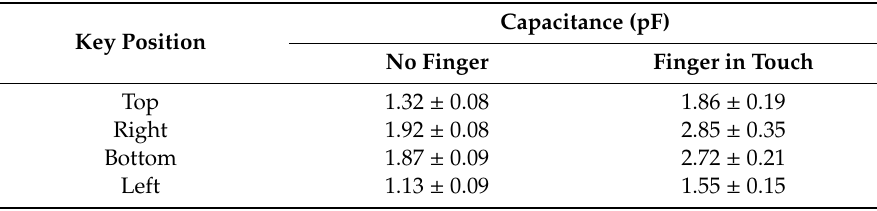
Table 4. Electrical capacitance values at 250 kHz for the capacitive sensors in case of finger in pression and not in